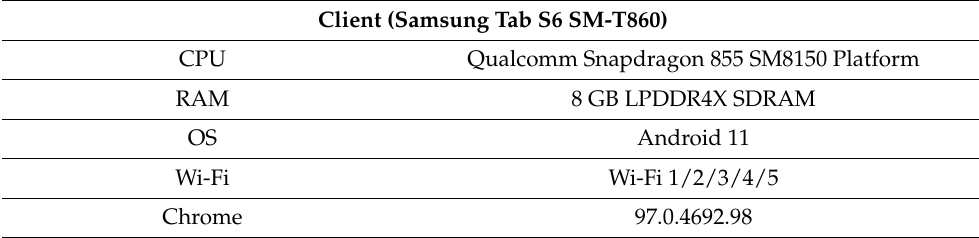
Table 1. Client information used in the experiment.